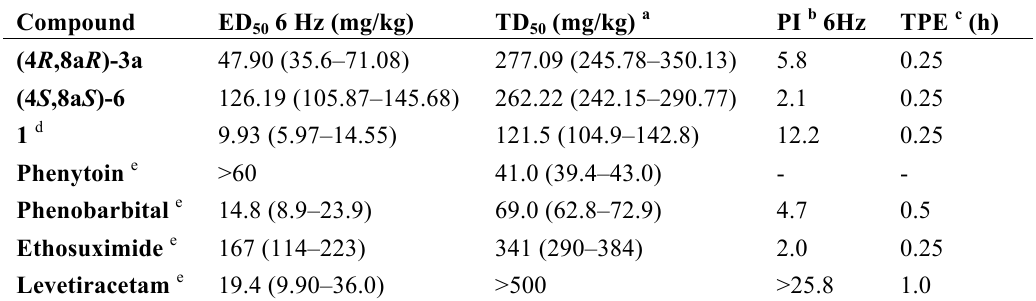
Table 4. Quantification studies of (4 R ,8a R )-3a and (4 S ,8a S )-6 in the 6 Hz and neurotoxicity tests following intraperitoneal (ip.) administration in